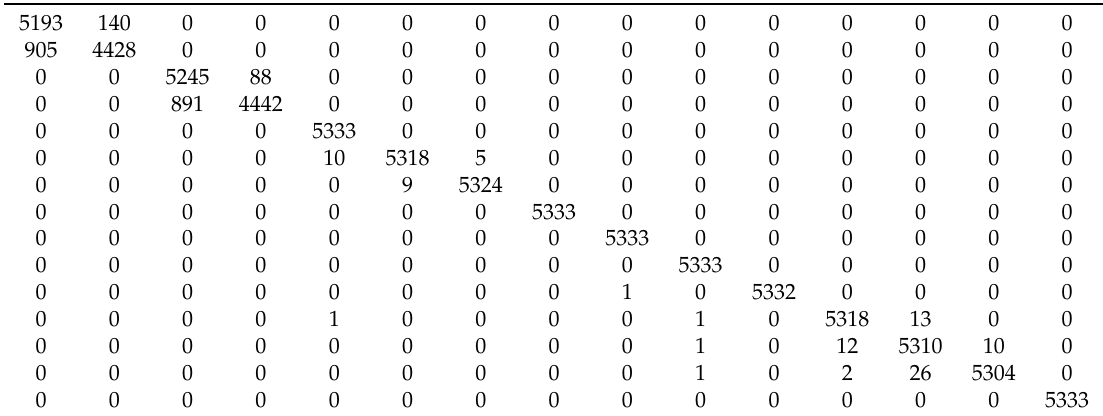
Table 5. Confusion matrix corresponding to C2R test evaluation with 10 epochs when 15 physical exercises are